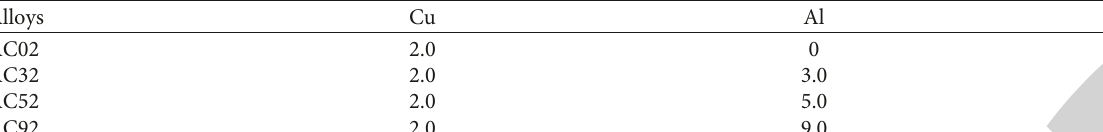
Table 1: Nominal chemical compositions of studied alloys